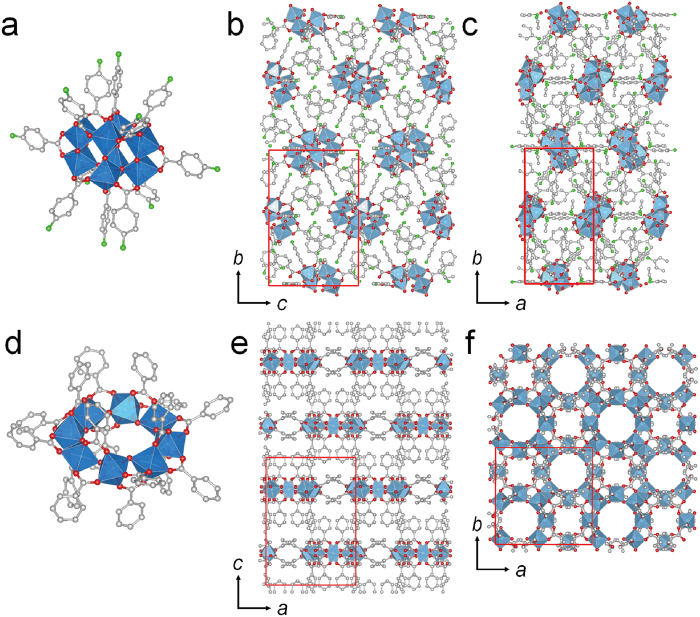
Crystal structures of titanium coordination clusters.Crystal structures of 1 and 2: (a) coordination geometry of 1. (b) view of 1 along a axis and (c) c axis. (d) coordination geometry of 2. (e) view of 2 along b axis and (f) c axis. The hydrogen atoms and solvent molecules are omitted for clarity. Each atoms of Ti, oxygen and carbon are coloured by blue, red and white. Ti is shown as a cation centred octahedral geometry.